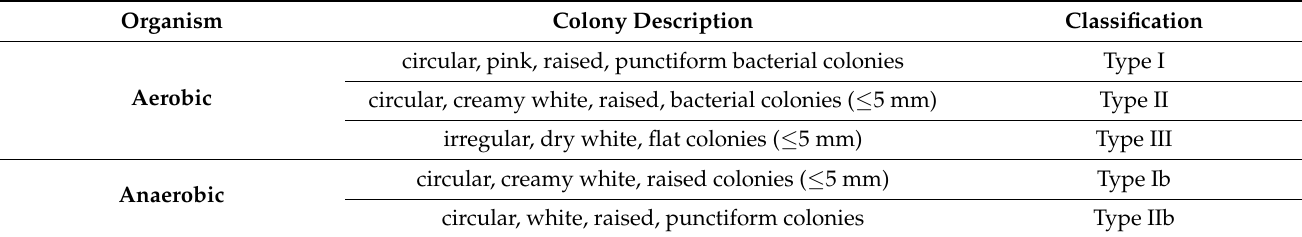
Figure 1. Methodology for the identification and characterization of zebrafish native gut potential probiotic bacteria. Adult female and male wild-type AB laboratory-reared zebrafish (LRZ) and pet-store zebrafish (PSZ) were used for analysis. Potential probiotic bacteria were isolated from the gut or gastrointestinal tract, and bacteria identified with high α -Gal content, namely A. veronii and P. entomophila , were used for probiotic formulations. Table 1. Phenotypic characteristics and classification of cultured bacteria isolated from zebrafish gut microbiota.